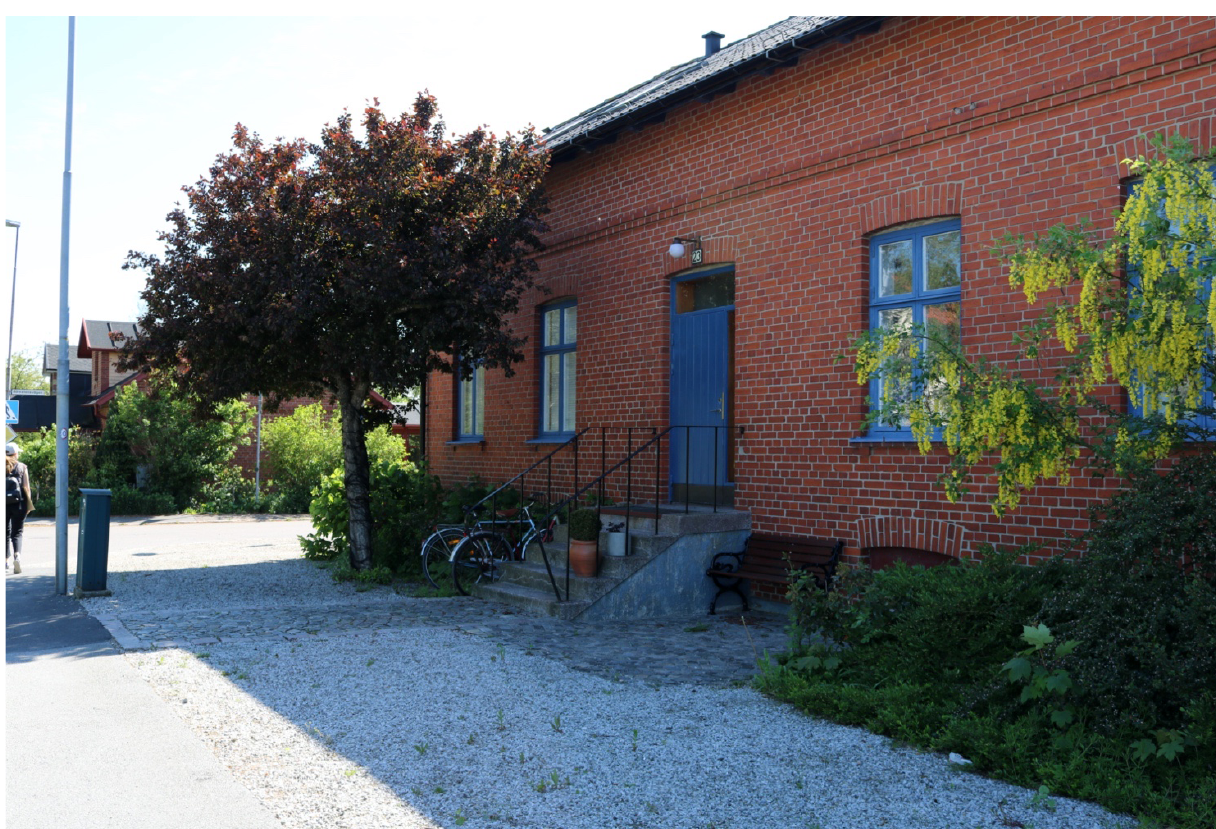
Figure 4. Bicycles parked outside a house in the old part of Stångby. Source: Author. cess of moralisation. If one experiences guilt when faced with the possibility of ruining the lives of the ones with whom/which one is bounded, it is because of the instinct to protect one’s own life. In the event of destruction of the life of the other, the one that my survival depends on, my destructive behaviour destroys not only someone else’s but also my own chances to survive. Guilt appears to incite a desire to self-help rather than a moral attitude towards the other. Even if feelings are activated towards fellow inhabitants, guilt appears deeply connected to the self (Butler, 2016). War operates on shorter timespans than climate change. However, the moral dilemma is shared between the problem realms. If I, coming from a place of discomfort or fear, act hastily and, for example, decide to preserve my lifestyle, I might cause harm somewhere else and overthe yearsthis